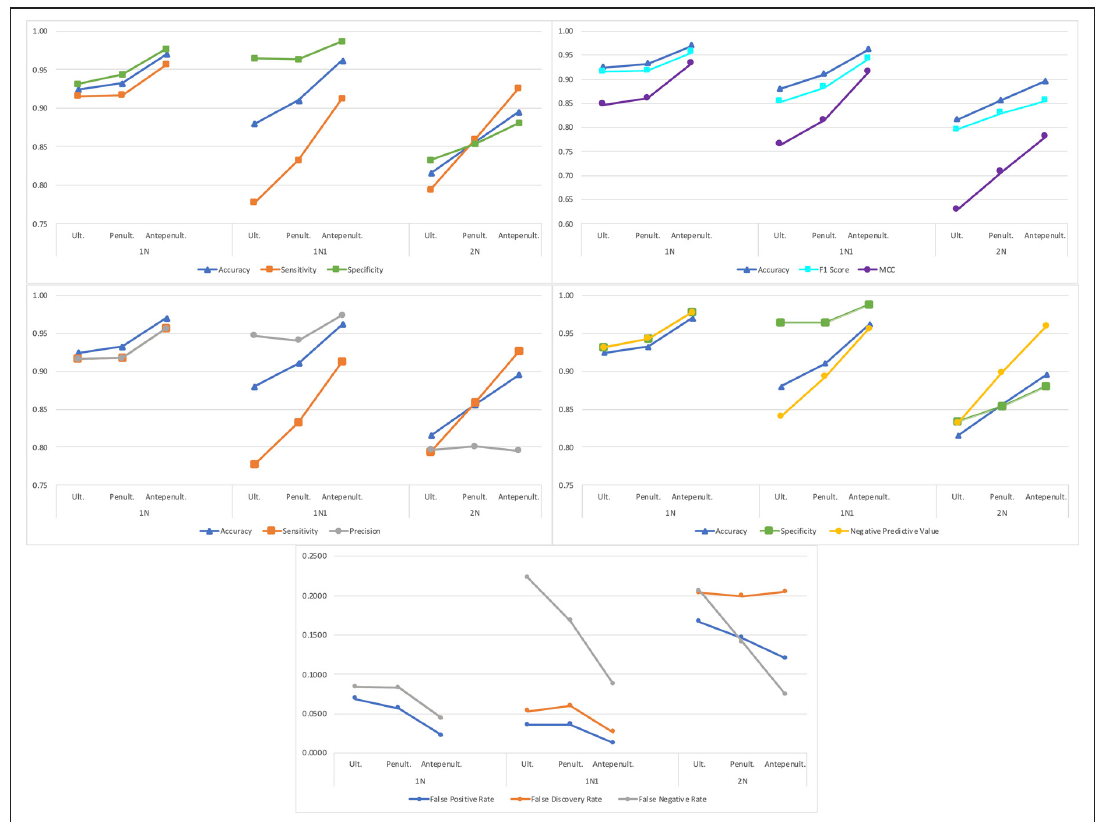
Figure 13: Discriminatory skills as a function of stress